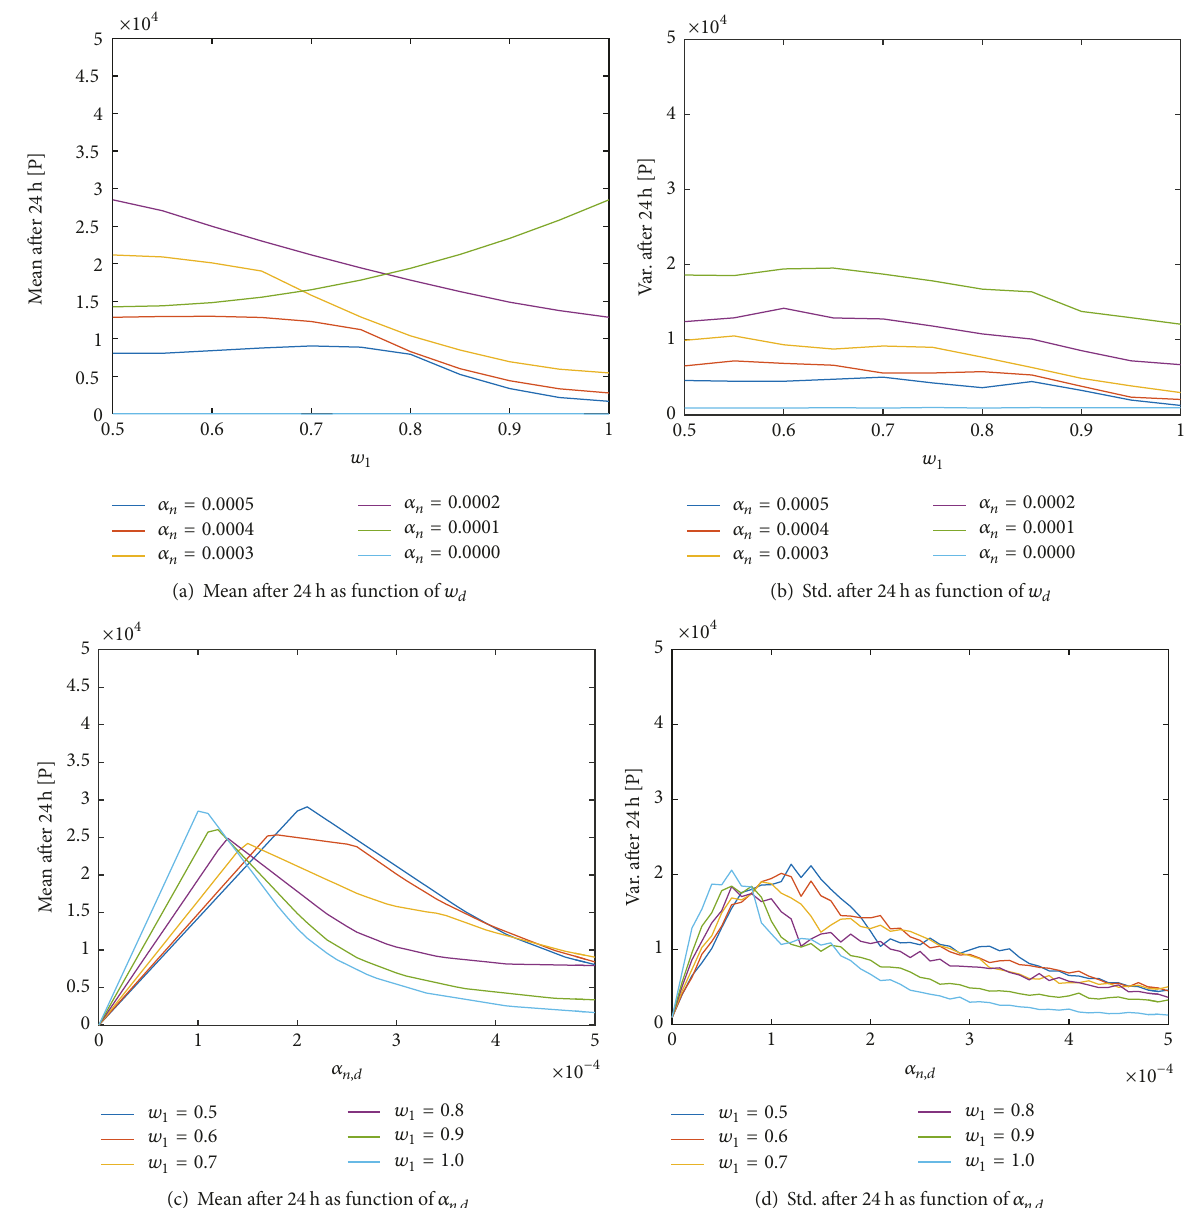
Figure 10: Case 3: visualisation of the mean and standard deviation of the number of pedestrians in the region given a certain distribution over the entrances as a function of 𝑤 𝑑 and 𝛼 𝑛,𝑑